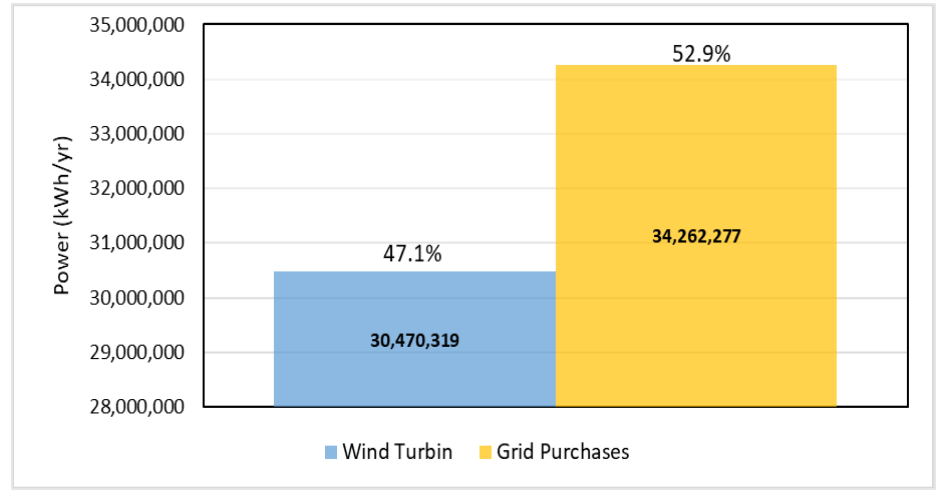
Figure 7. Grid vs. wind energy production per year .